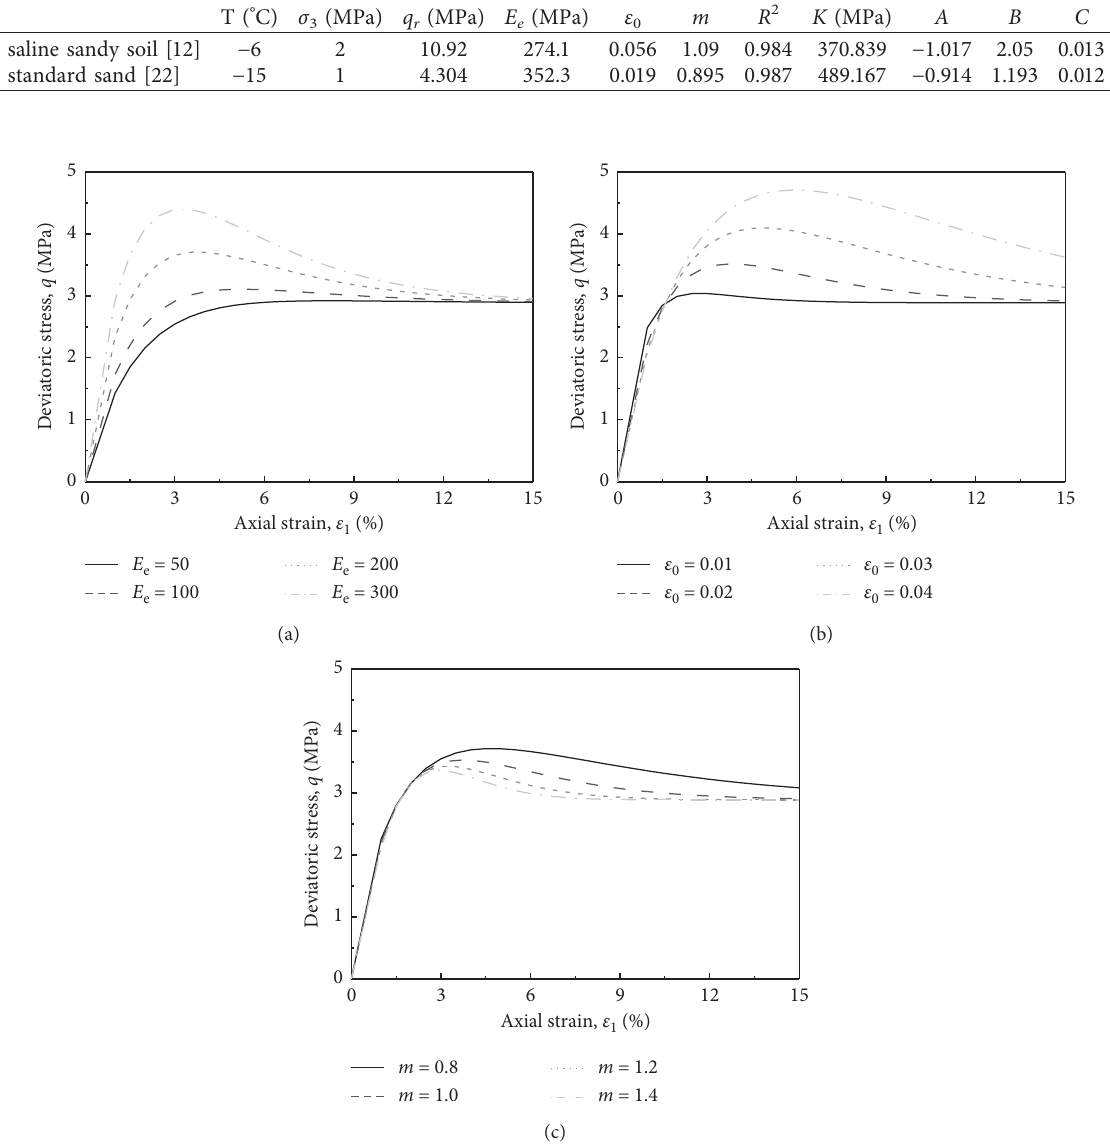
Figure 16: Deviatoric stress-strain curves for different values of parameters (a) e